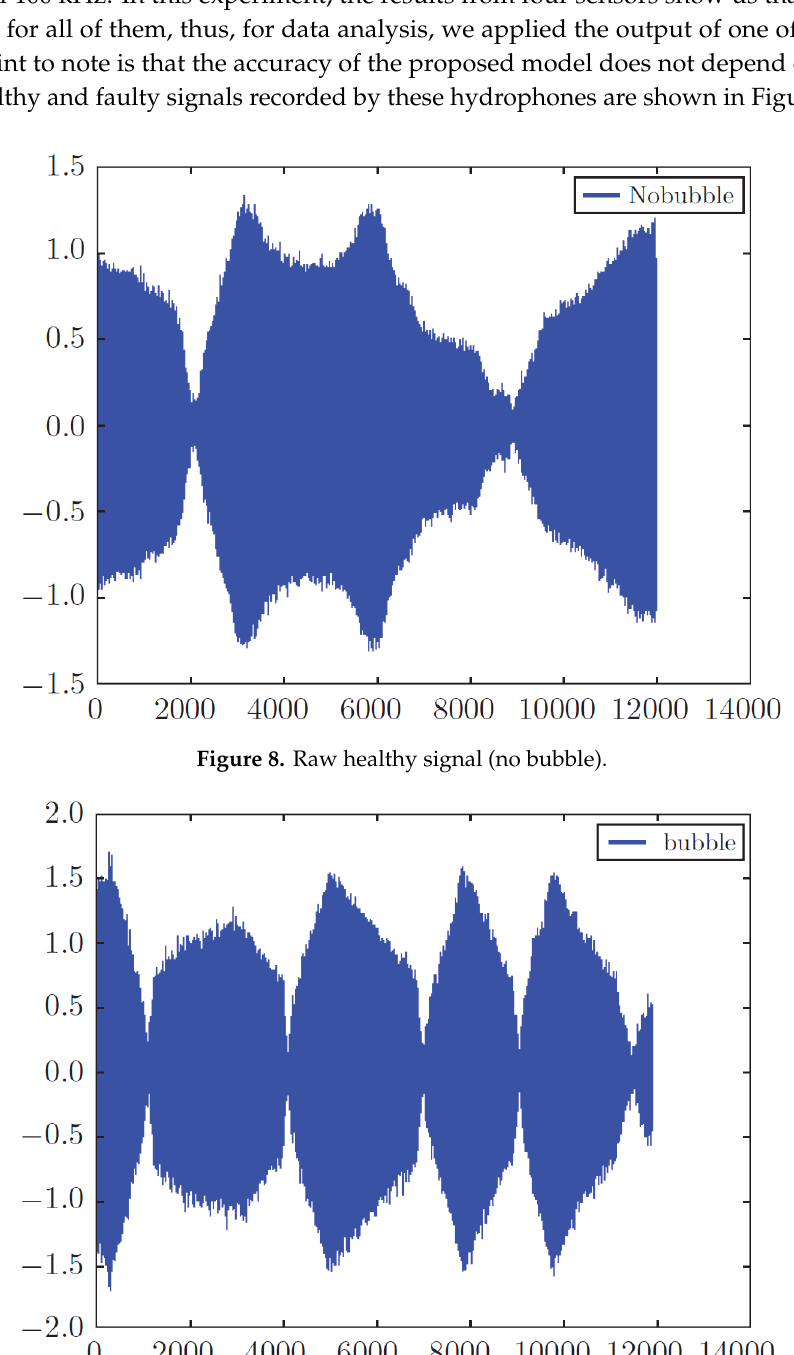
Figure 9. Raw faulty signal (bubble).